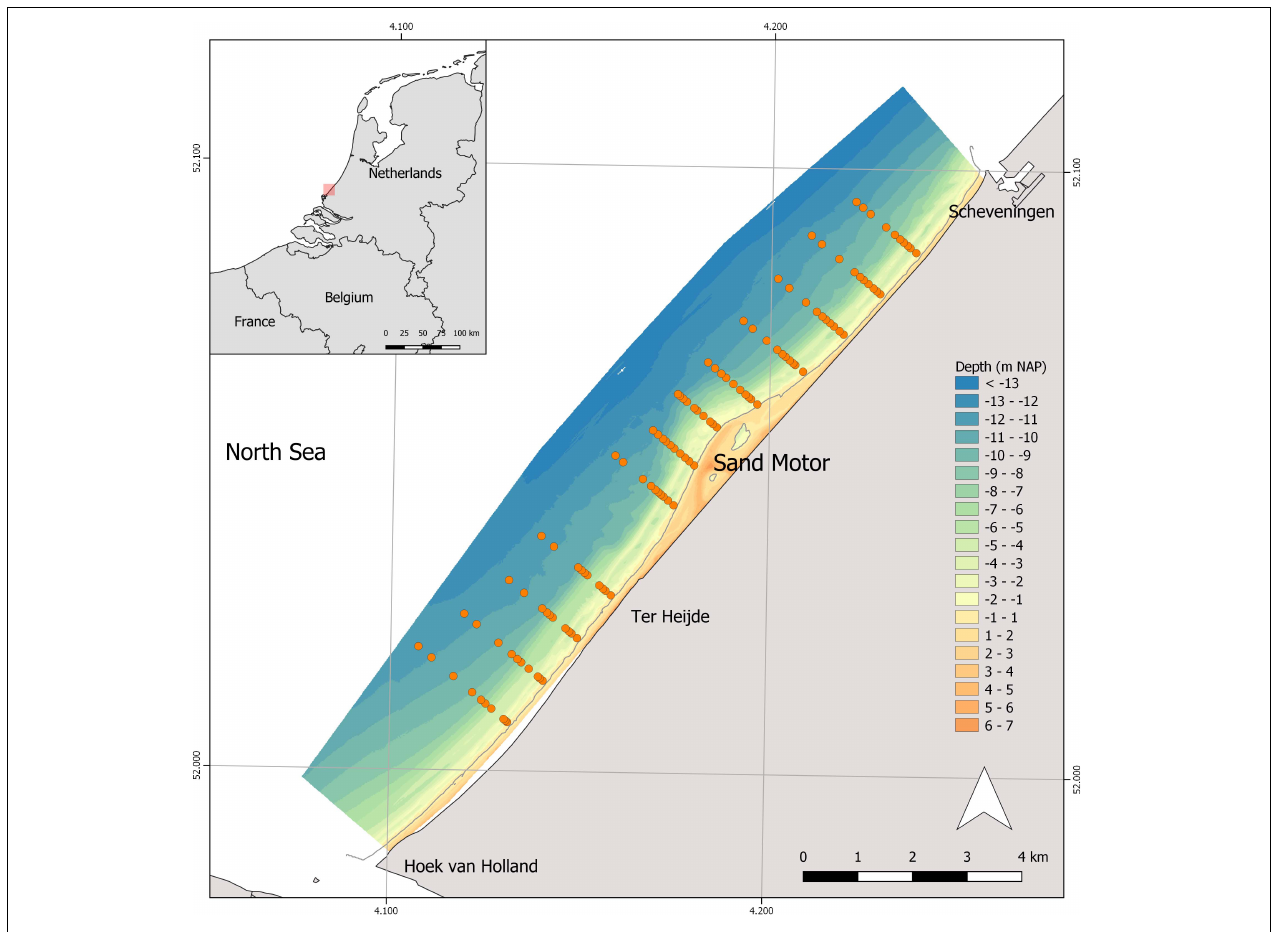
FIGURE 1 | Map of the study area along the Dutch coast. Indicated is the bathymetry of the zone and the position of the sampling stations in 2017.